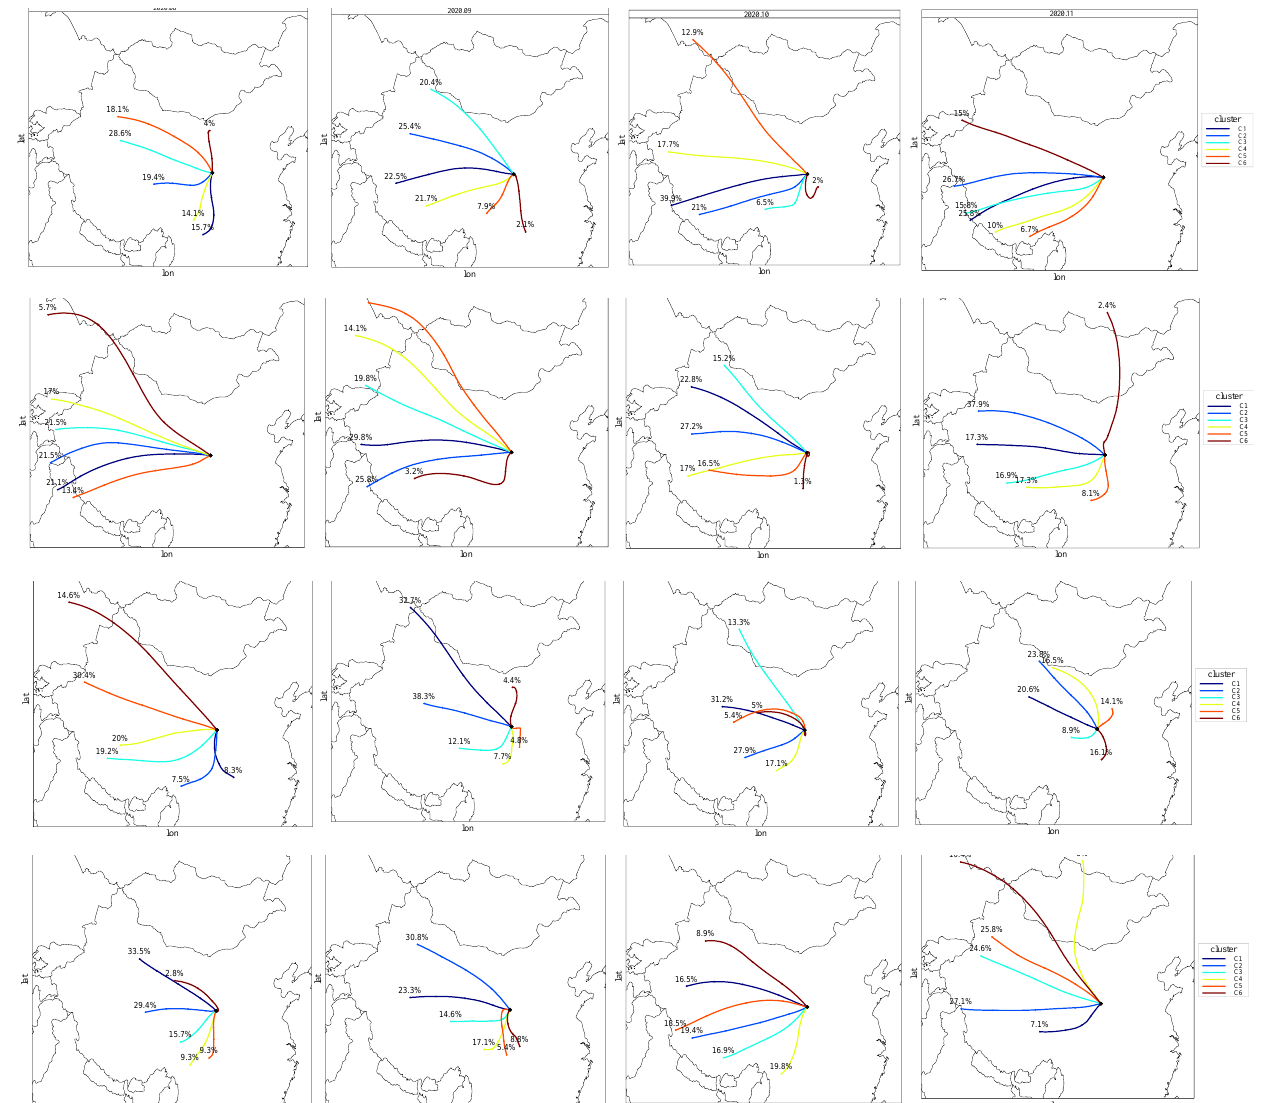
Figure 10. The 48-h backward trajectory cluster into six clusters from August 2020 to November 2021. Three different methods were used to analyze the potential sources of CCN and PSCF (potential source contribution function). As shown in Figure 11a, the spring mainly comes from the southwest direction of the LPS, and is considered the main source of Gansu. The urban agglomeration, as the center, has a greater contribution to the CCN of LPS, which indicates the impact of pollutants generated by human activities on the CCN observations. The contribution of pollution sources in the summer comes from the south, mainly due to the influence of the summer monsoon, and the northward lift of the southwest warm and humid airflow affects the LPSs. In autumn and winter, the source of the CCN is mostly from the northwest, and Xinjiang contributes more to this, mainly due to the influence of the winter monsoon, which is caused by cold air from Siberia traveling